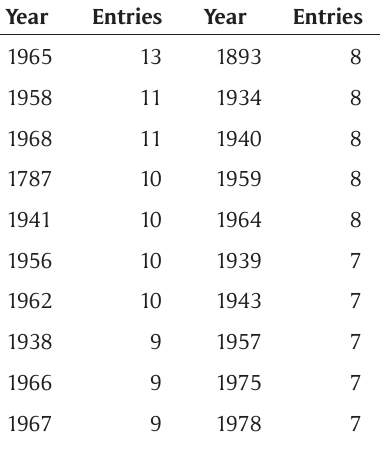
Table 2: Most frequent years of origin of the works of